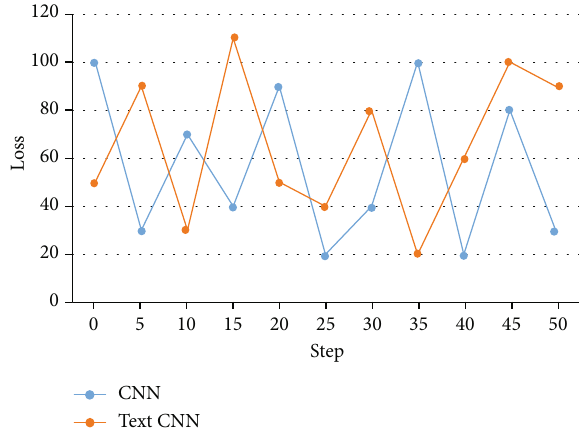
Figure 5: Curve of loss with time during training.